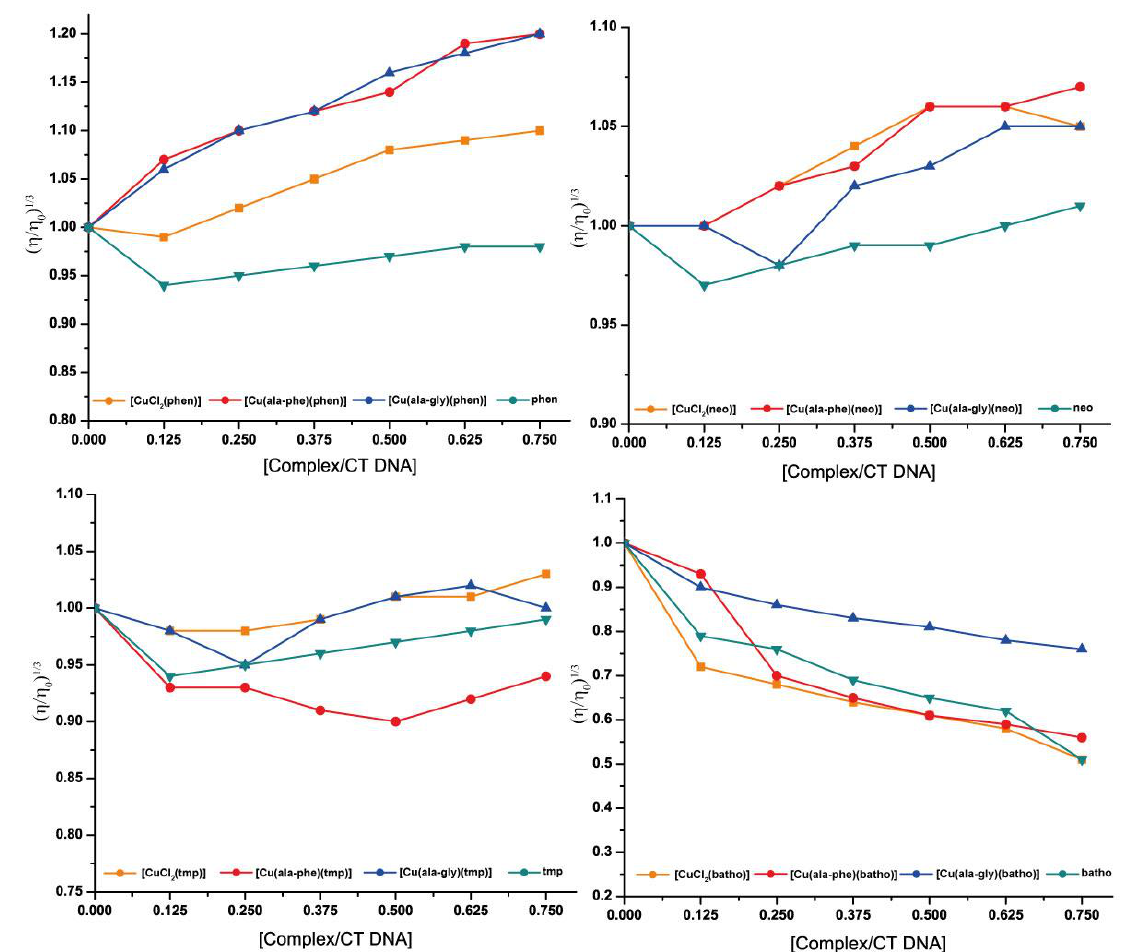
Figure 4. Effect of the increasing concentration of complexes on the relative viscosity of CT -DNA. [DNA] = 150 μM, for the free diimine, Cu -diimine and [Cu(L-dipeptide)(diimine)] for diimine: phen, neo tmp and batho.